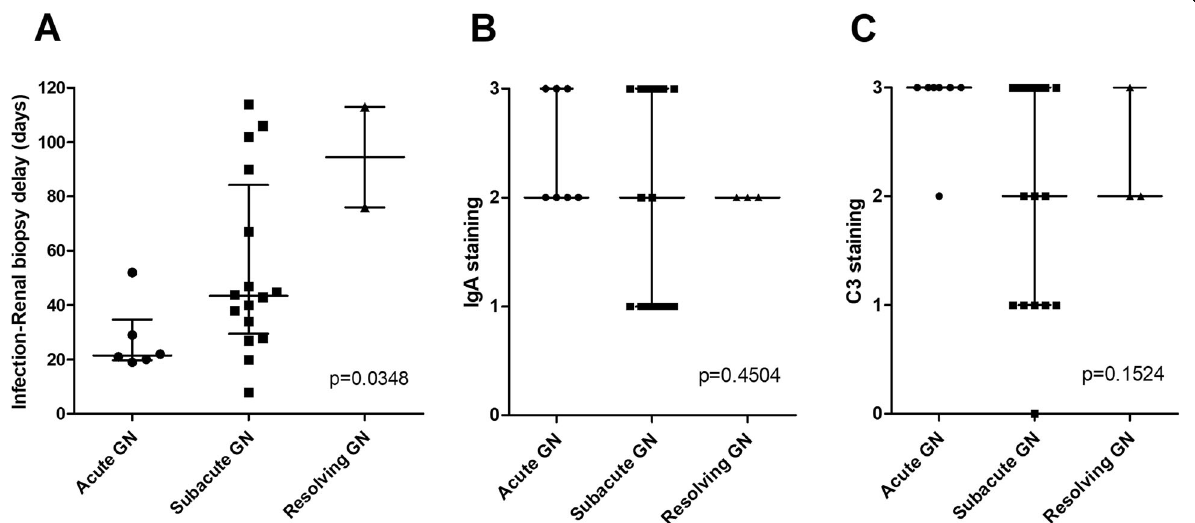
Fig. 2 Infection-to-biopsy delay and immunofluorescence according to histologic pattern. a : Delay in days between documentation of infection and renal biopsy according to histologic pattern; b : IgA intensity staining according to histologic pattern; c : C3 intensity staining according to histologic pattern. Values are expressed as median and interquartile range. Abbreviations: GN: